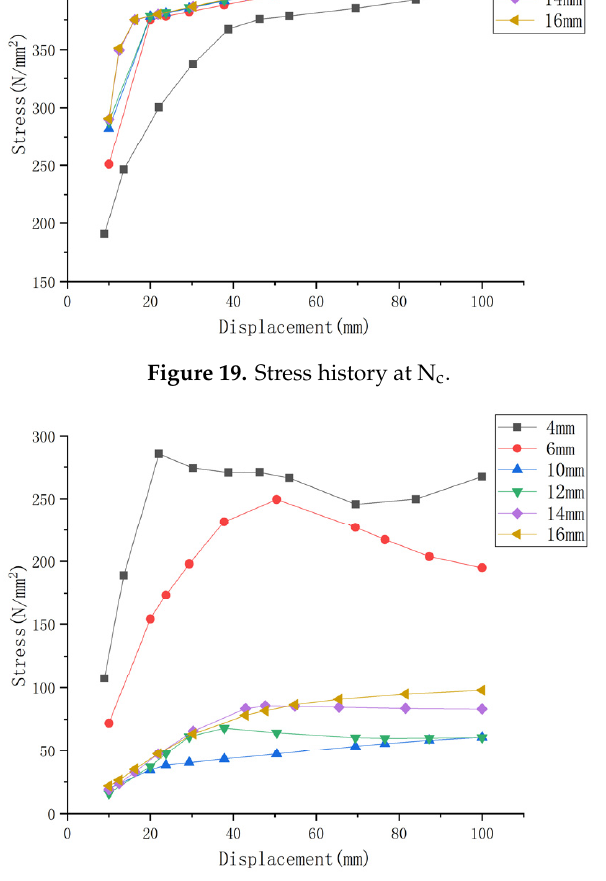
Figure 20. Stress history at E p .